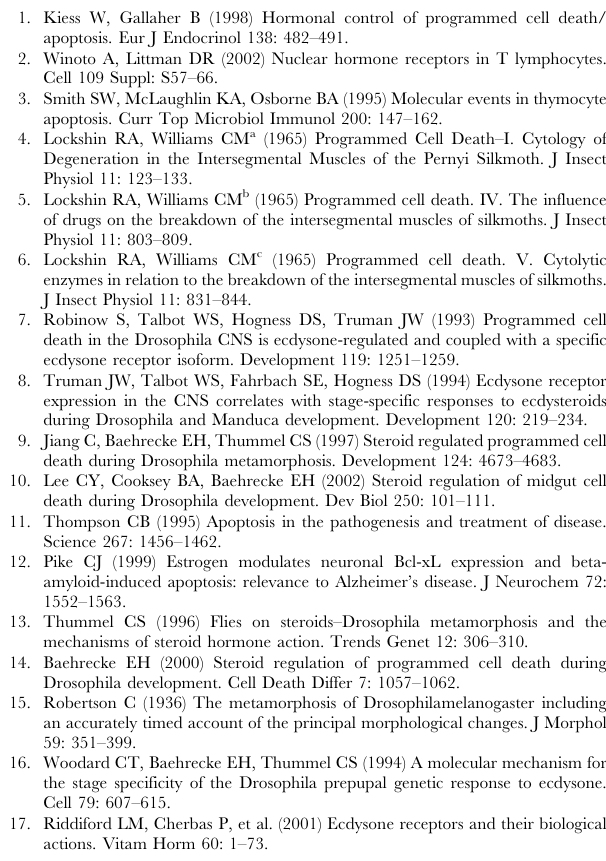
Figure S1 RNAi of some Atg genes shows reduced viability in the absence of ecdysone. Figure S2 Analysis of cell proliferation by the BrdU incorpora- tion assay in dsRNA-treated l(2)mbn